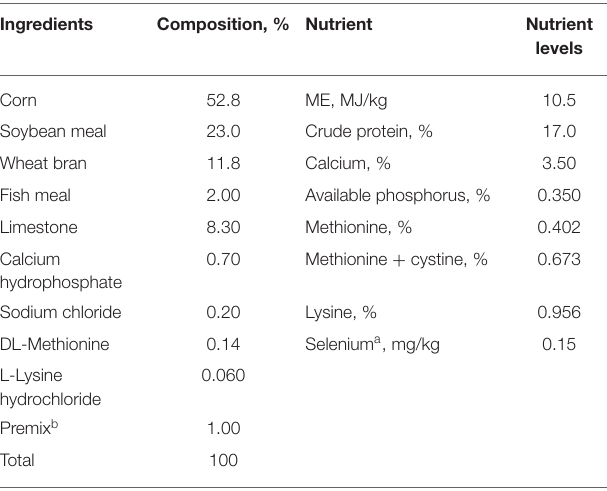
TABLE 1 | Ingredients and nutrient levels of the basal diet (as-fed